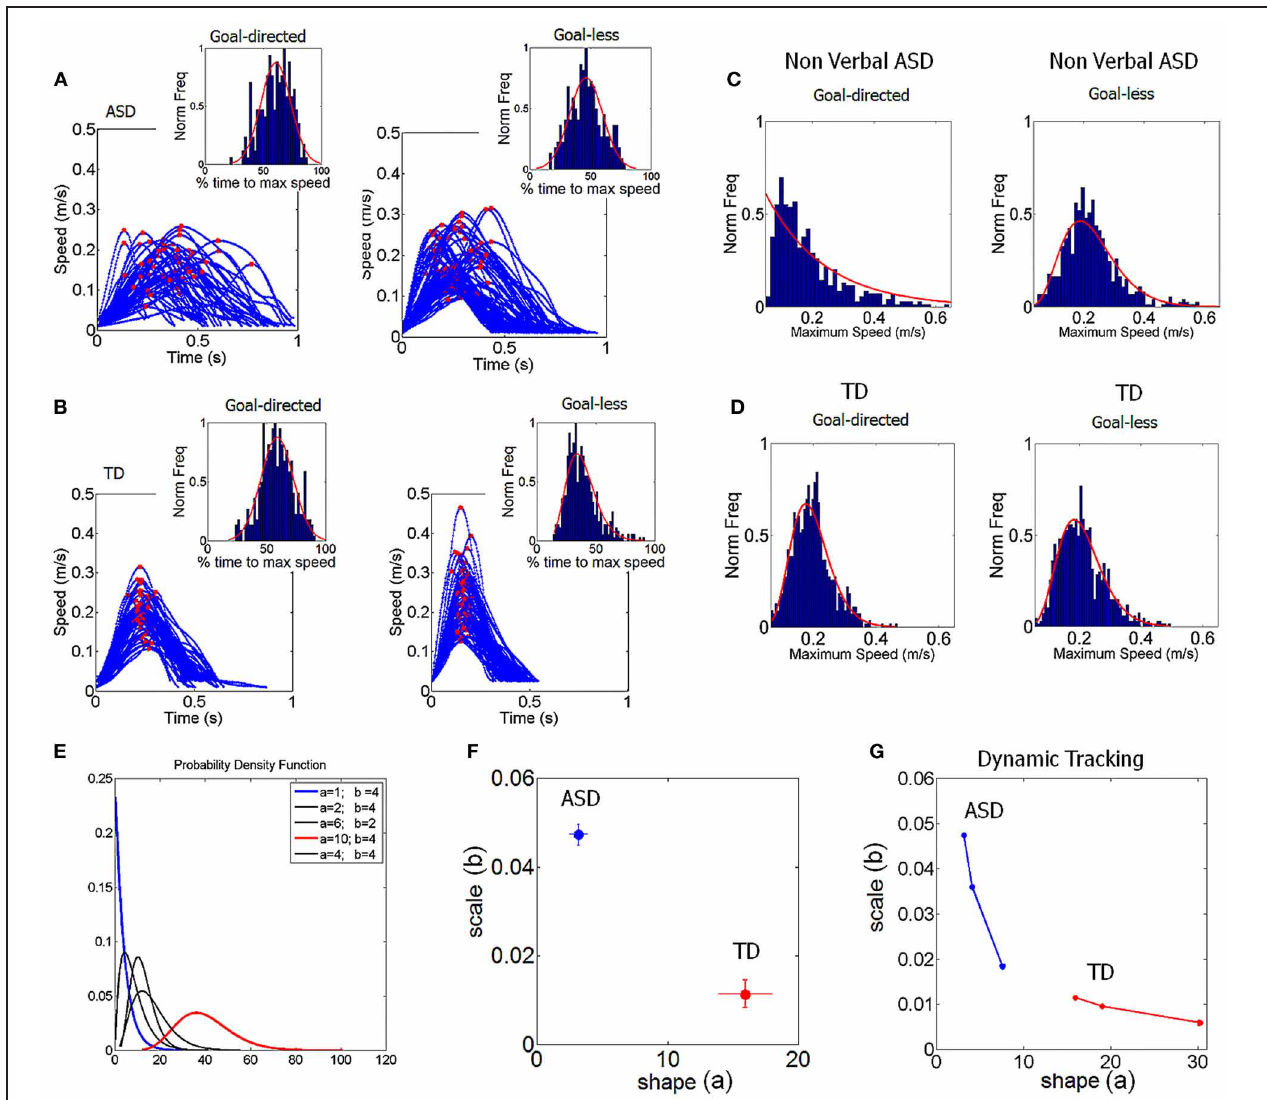
FIGURE 6 | Simple objective metric to screen idiosyncratic differences and to dynamically track progress in ASD. (A) Instantaneous speed profiles from a low-functioning non-verbal child with ASD across a subset of trials in one session. Red dots mark the maximum speed value of each trial, goal-directed-forward (left) vs . incidental goal-less segments (right). Insets are the normalized frequency distributions of the percent of movement time (s) to reach the maximum speed compiled across sessions. Over thousands of repetitions, this parameter distributes normally in the child with ASD for goal-less reaches. (B) Speed profiles of a TD child from a subset of trials in a session (age matched control). The distribution of the percent of time to reach the maximum speed for goal-less segments is skewed. This was the general trend across groups. (C) Refers to (A) , normalized frequency distribution of the value of the speed maximum compiled across sessions for thousands of trials (goal-directed reaches